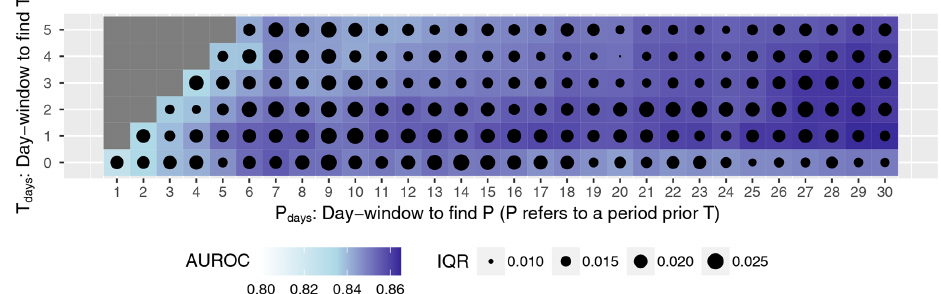
Figure 5. Result of the pairwise selection of precipitation variables using leave-locations-out cross-validation. The highest AUROCs (mean 0.87; median 0.86) were calculated when combining the day-window T days 1 with the day-window P days 29. T days 1 refers to the 2d cumulative precipitation at day 0 plus day 1, while P days 29 refers to the 28d prior T . The variability of AUROCs is shown by the interquartile range